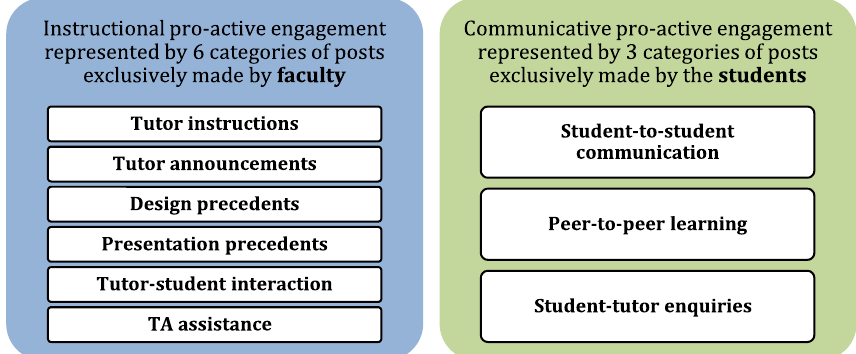
Fig. 9 Identified categories of posts as form of pro-active engagement and who posted